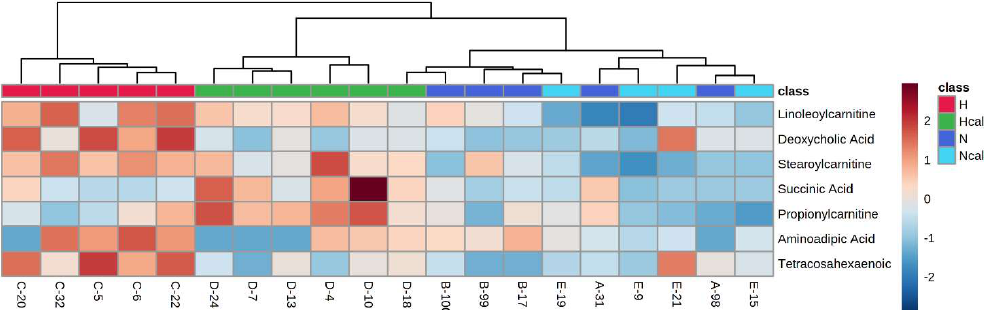
Figure 4. Heatmap of significant metabolites. H—High-fat diet group; N—normal diet group; Hcal—High-fat diet group with calafate; Ncal—Normal diet with calafate. C-20 to E-15 are the labels of each analyzed sample.